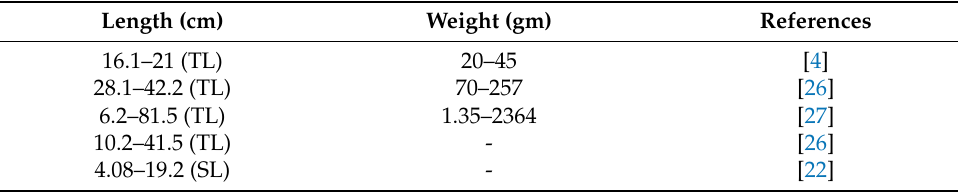
Table 1. Length-weight records of B. bagarius